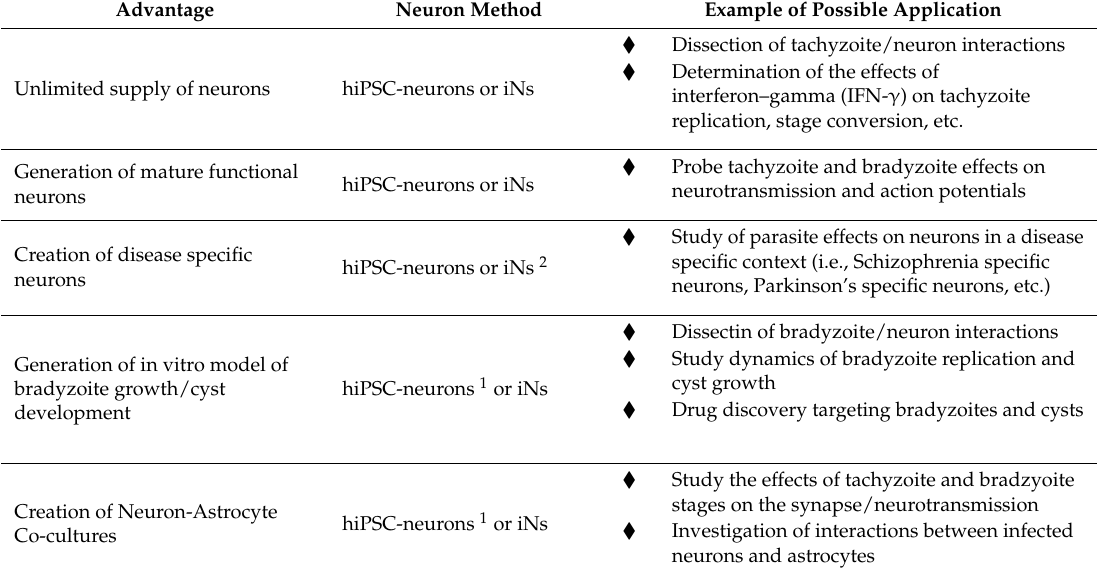
Table 1. Advantages of reprogrammed neurons with potential applications for research on host/parasite interactions in neurons and biology of parasite in the